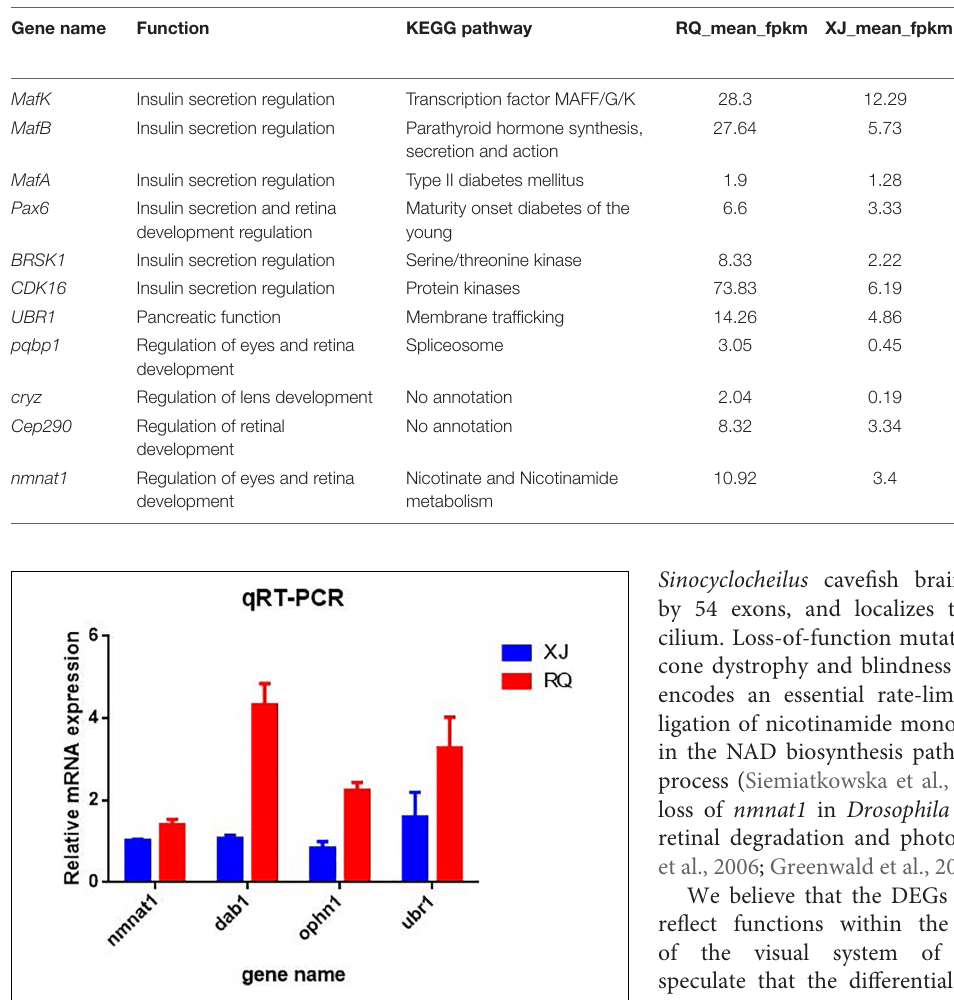
TABLE 6 | Candidate DEGs that related to cave adaptability.